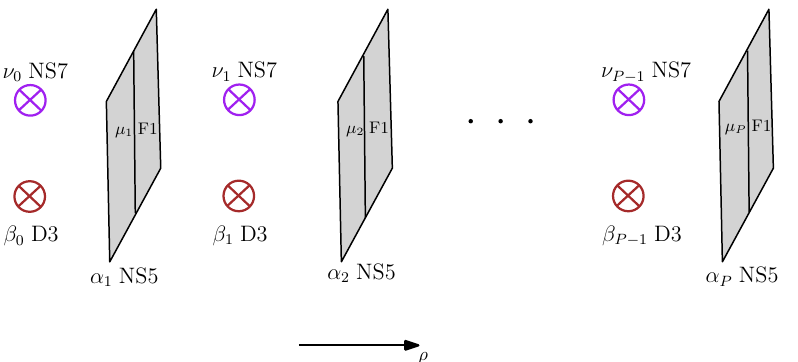
Figure 6 . Hanany-Witten brane set-up associated to the T+S duals of our solutions.